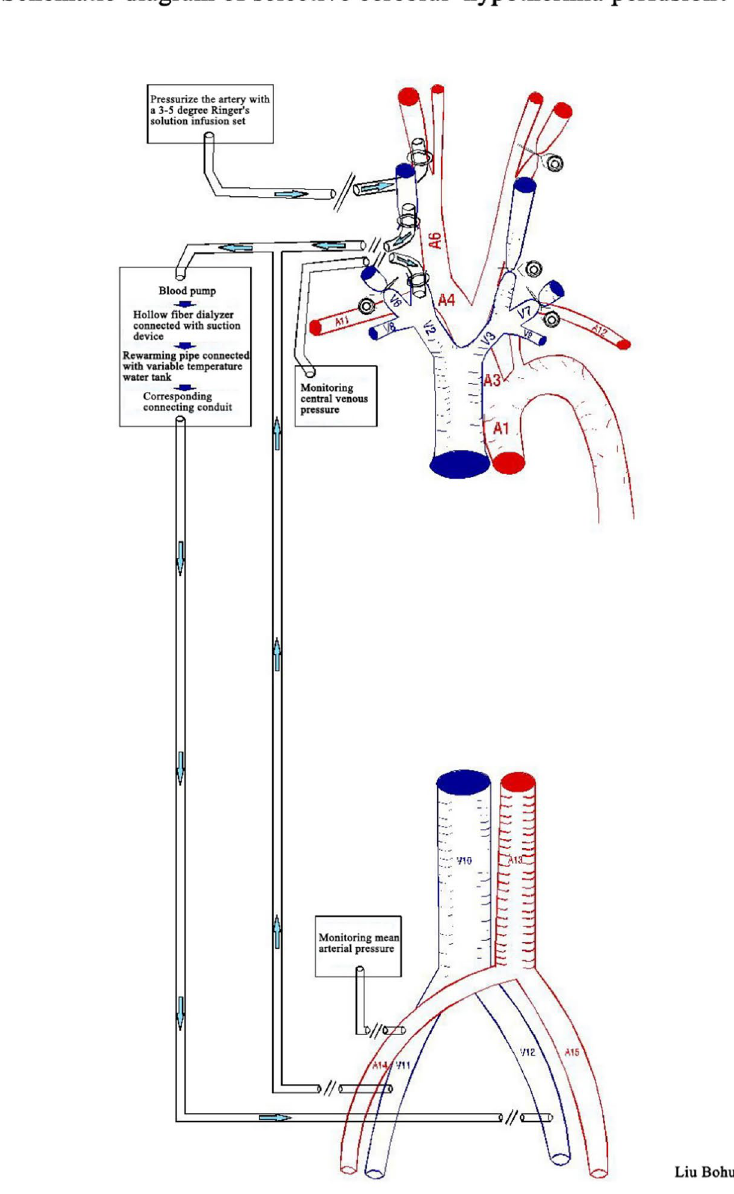
Figure 1. The map of selective cerebral deep hypothermic perfusion. A1 ascending aorta, A2 aortic arch, A3 common trunk, A4 cephalic trunk, A5 left common carotid artery, A6 right common carotid artery, A7 right internal carotid artery, A8 left internal carotid artery, A9 right external carotid artery, A10 left external carotid artery, A11 right subclavian artery, A12 left subclavian artery, A13 abdominal aorta, A14 right femoral artery, A15 left femoral artery, V1 superior vena cava, V2 right cephalic arm vein, V3 left cephalic arm vein, V4 right internal jugular vein, V5 left internal jugular vein, V6 right external jugular vein, V7 left external jugular vein, V8 right subclavian vein, V9 left subclavian vein, V10 inferior vena cava, V11 right femoral vein, V12 left femoral